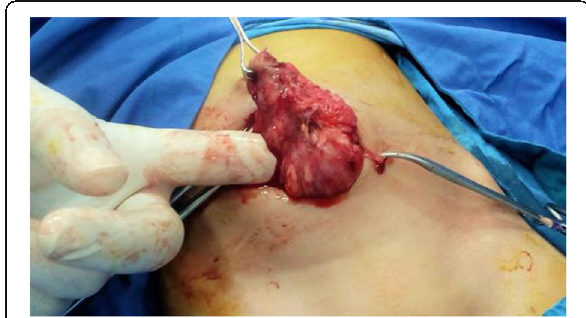
Fig. 3 Open surgical excision of urachal